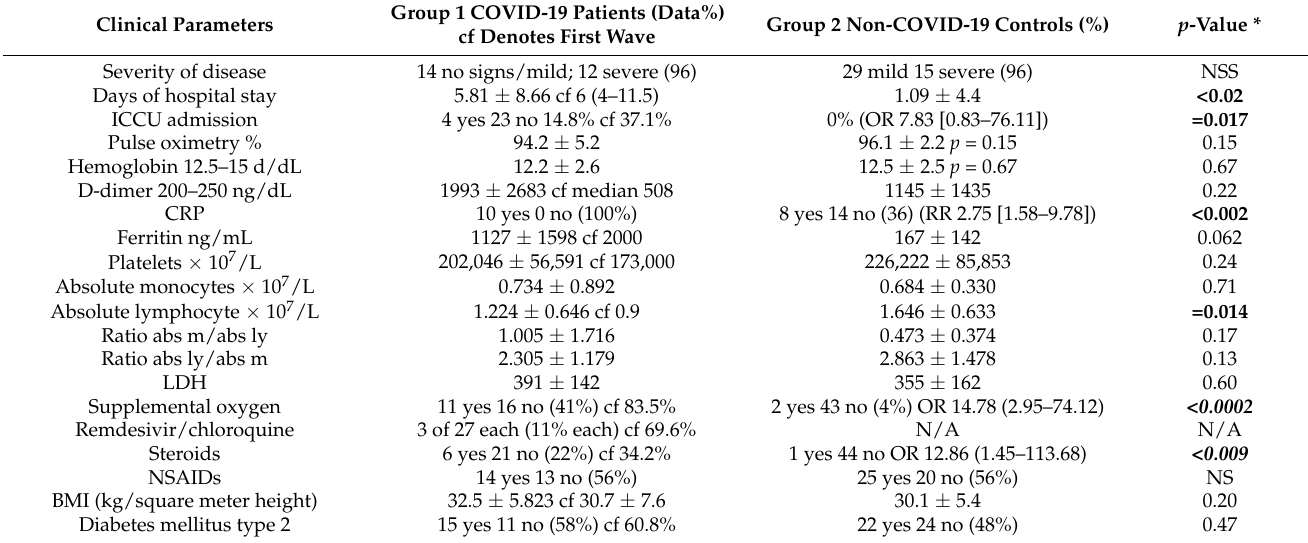
Table 2. Clinical details of PCR confirmed group 1 COVID-19 patient and first-wave patients with comparison to PCR-negative controls with signs of